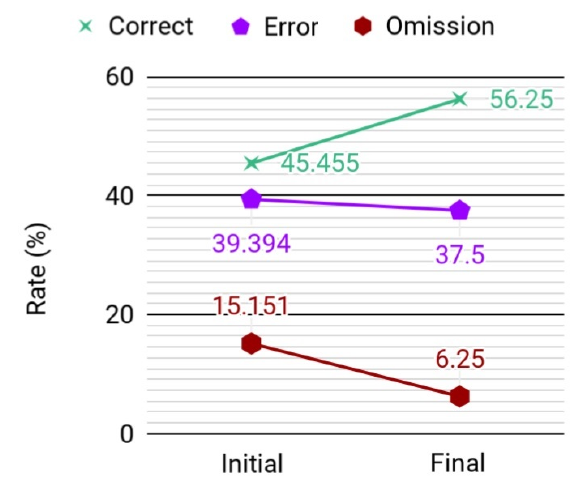
Figure 1. Changes in correct, error, and omission rates.